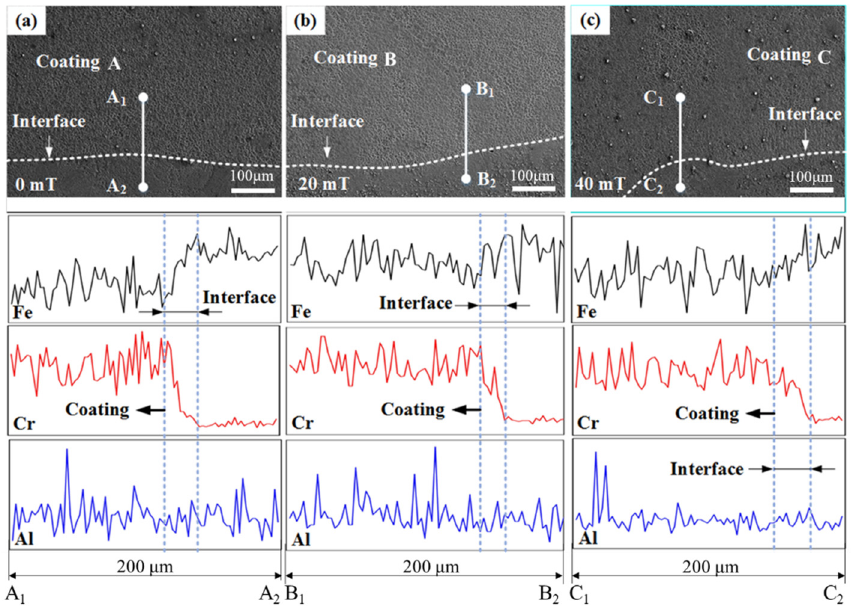
Figure 6. SEM images of metallurgical bonding and the line scanning images of coatings ( a ) A (0 mT), ( b ) B (20 mT), and ( c ) C (40 mT).